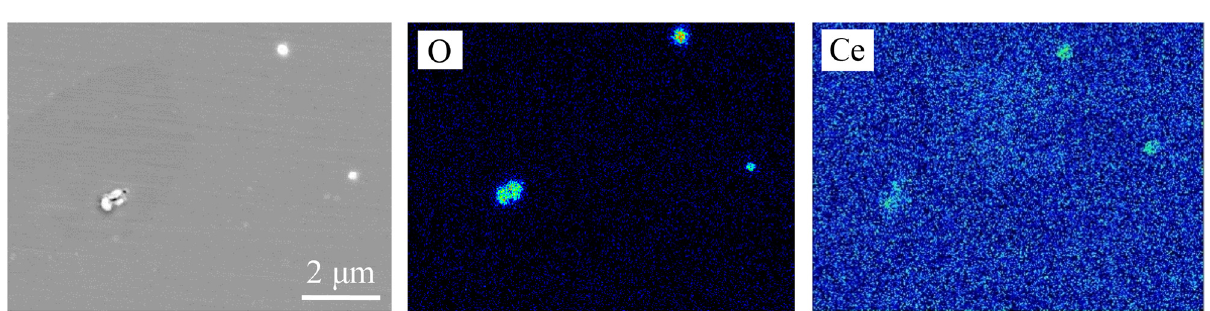
Figure 3: EPMA images of elemental distribution of inclusions in FSS2